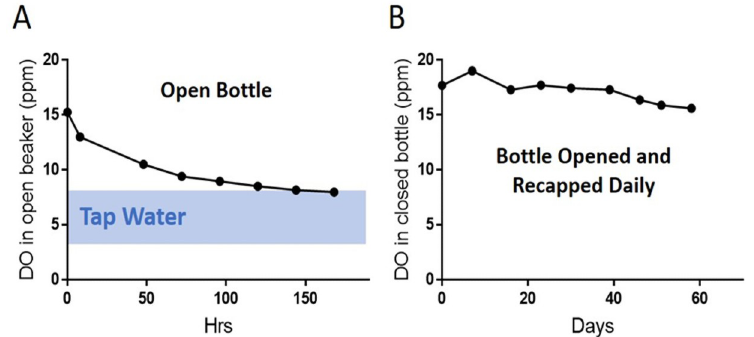
Fig 2. The dissolved oxygen (DO) level in ELO water measured using a dissolved-oxygen meter at sea level atmospheric pressure (A) in a bottle kept open for 7 days. The blue band indicates typical range of DO in tap water. (B) ELO water DO was measured in a bottle that was opened and recapped daily. DO was found to be still high at Day 58. The DO in ELO water is about 2 times higher than in tap water. This higher DO is stable, maintained over a considerable time